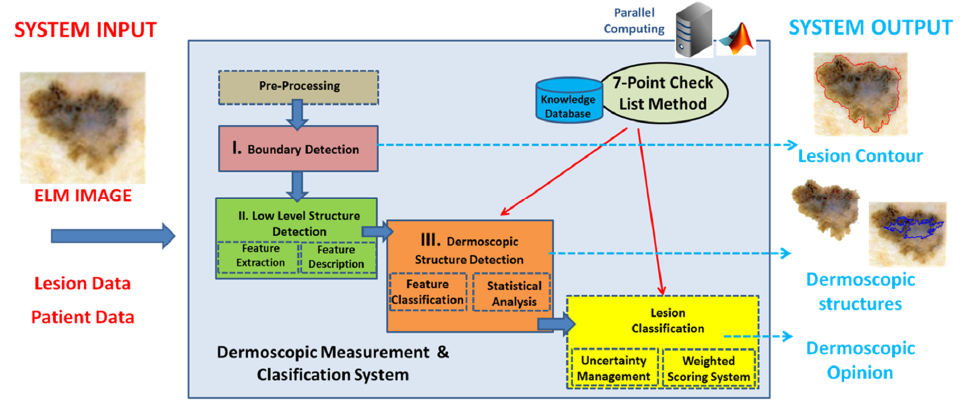
Figure 1. The software system for automatic diagnosis of melanoma.